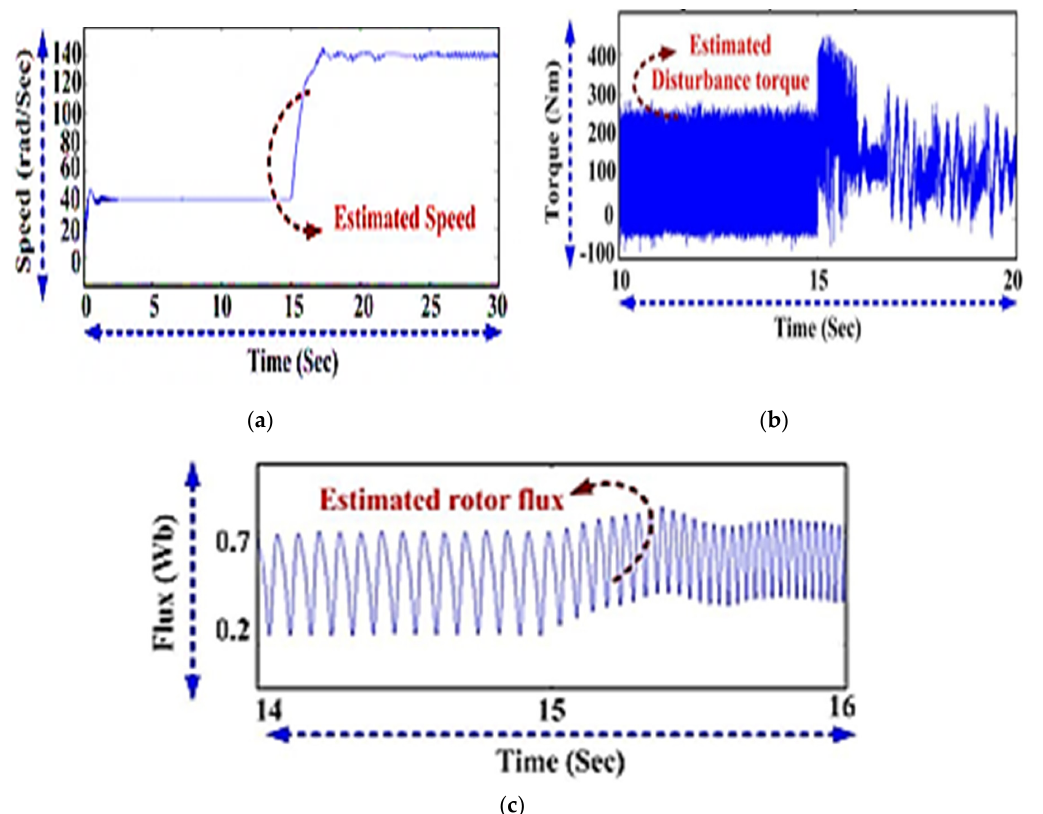
Figure 9. SMLO1: ( a ) estimated speed; ( b ) estimated torque and ( c ) estimated rotor flux.